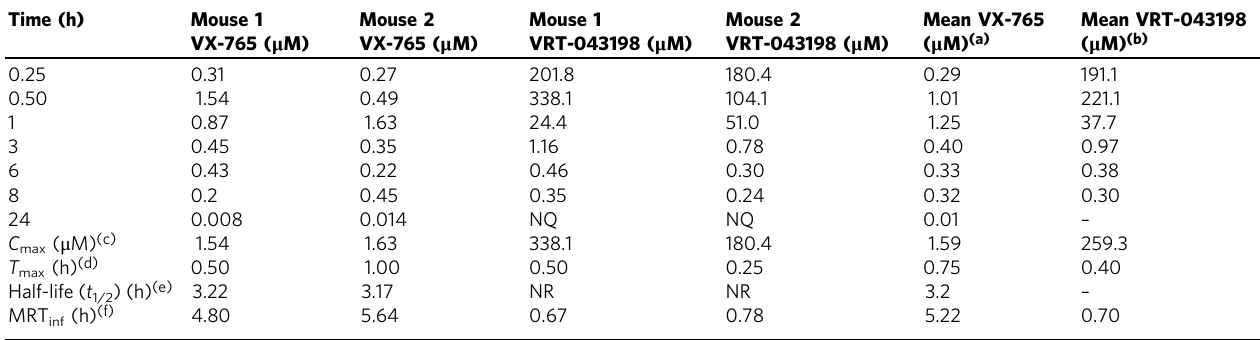
NQ: not quanti fi able. No peak of below lower limit of quanti fi cation: 0.05 μ M for VX-765 and 0.098 μ M for VRT-043198. NR: not reported. Only two points used for terminal slope calculation or the span of the terminal phase is too short to allow for accurate estimation of half-life. Individual data points showing VX-765 and VRT-043198 concentrations up to 24h post-injection ( n = 2 per time point). (a) VX-765 and (b) VRT-043198 mean concentrations at each time point. (c) Maximum concentration achieved ( C max ), (d) time to reach C max ( T max ), (e) half-life ( t 1/2 ) and (f) mean residence time (MRT) in plasma for VX-765 and